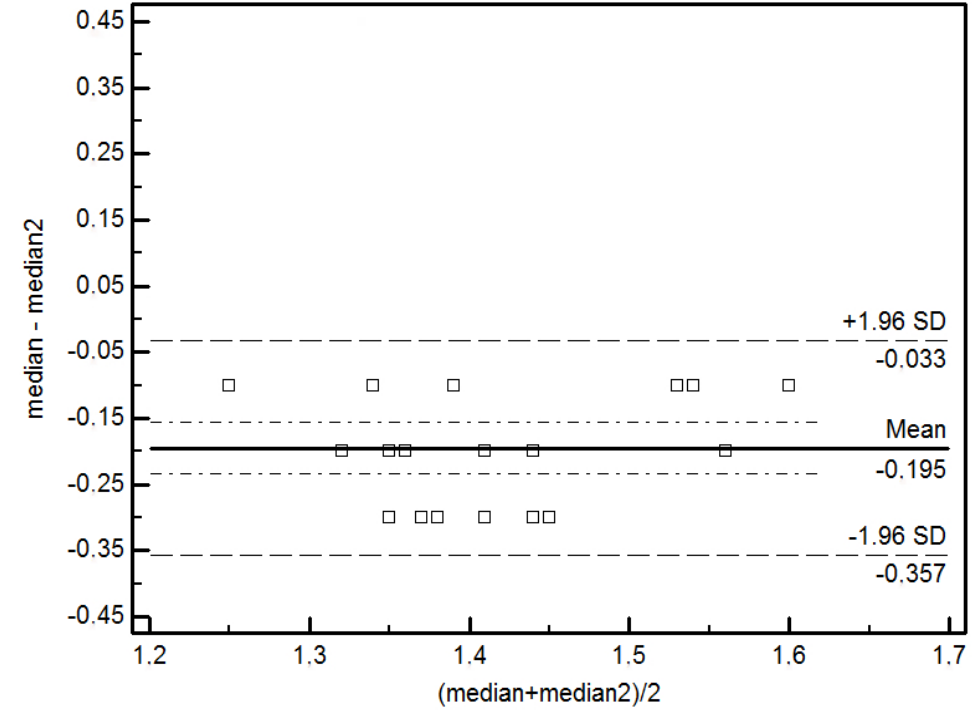
Figure 1. Bland-Altman analysis of the repeatability of LDPI measurements under different experimental conditions. Bias is represented by the solid line (–0.195). The two dotted lines represent the limits of agreement for repeatability (–0.357;